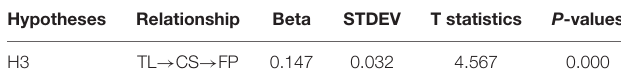
TABLE 6 | Structural model assessment [indirect (mediation)].